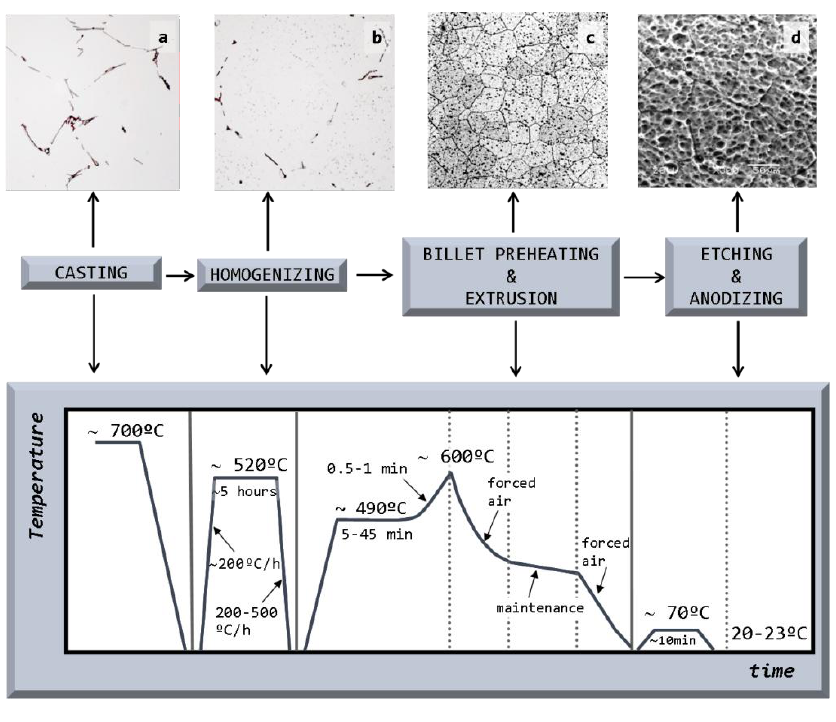
Figure 1. The different stages of the manufacturing process of extrusions from semi-continuous cast billets. Correlation with its corresponding microstructure: ( a ) after casting; ( b ) in the as-heat treated condition; ( c ) after extrusion; and ( d ) after